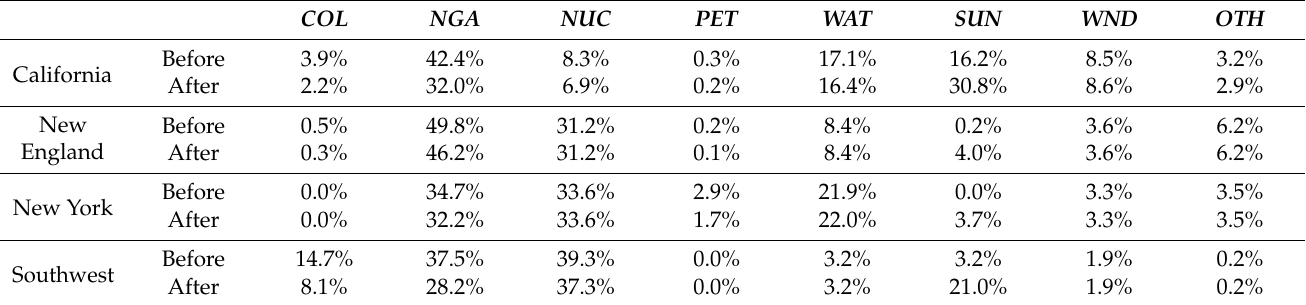
Table 3. 100% Solar Penetration—Generation by region and sources before and after adding the hypothetical solar